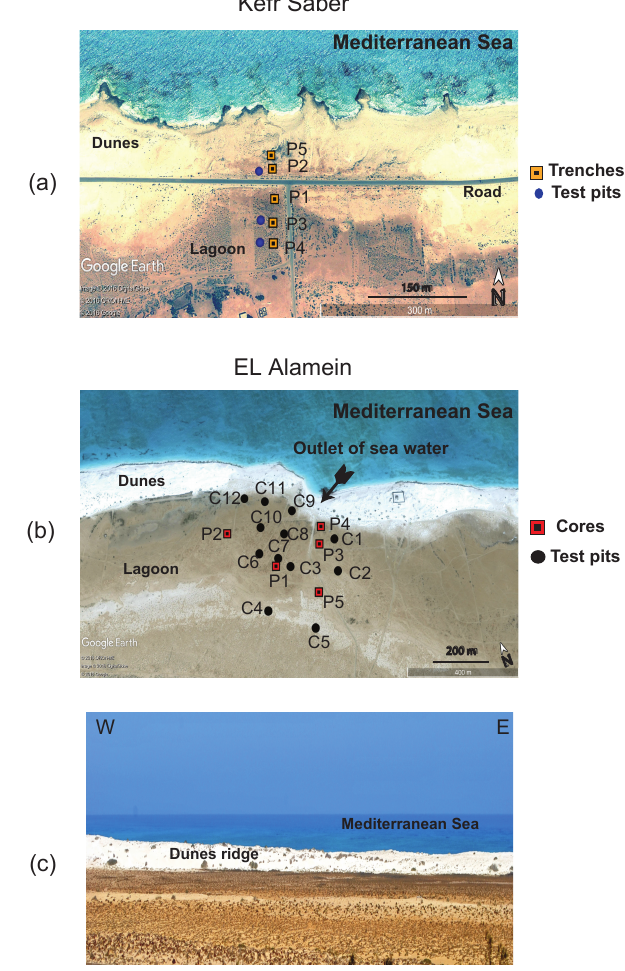
Figure 2. Location of trenches and core sites at (a) Kefr Saber, (b) El Alamein (see Fig. 1), and (c) dune ridge and a lagoon south of the Mediterranean Sea as a selected site for coring and trenching at the El Alamein